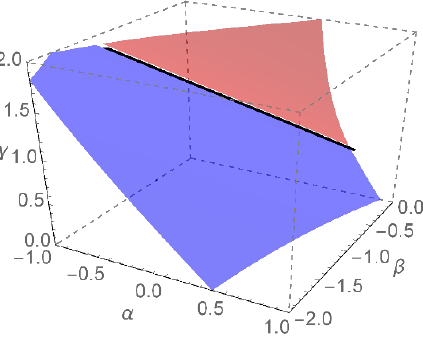
Figure 1. The ( (cid:11); (cid:12); (cid:13) ) region which gives the linear- T resistivity in low temperature limit. The (red/blue) surface corresponds to the (class II/class III) solution. The black line, which is the intersection of the red and blue surface, corresponds to the class I. Class IV does not allow the linear- T